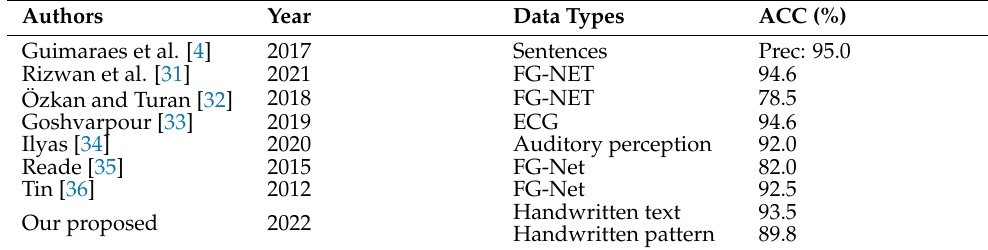
Table 12. Accuracy comparison with the methods in the